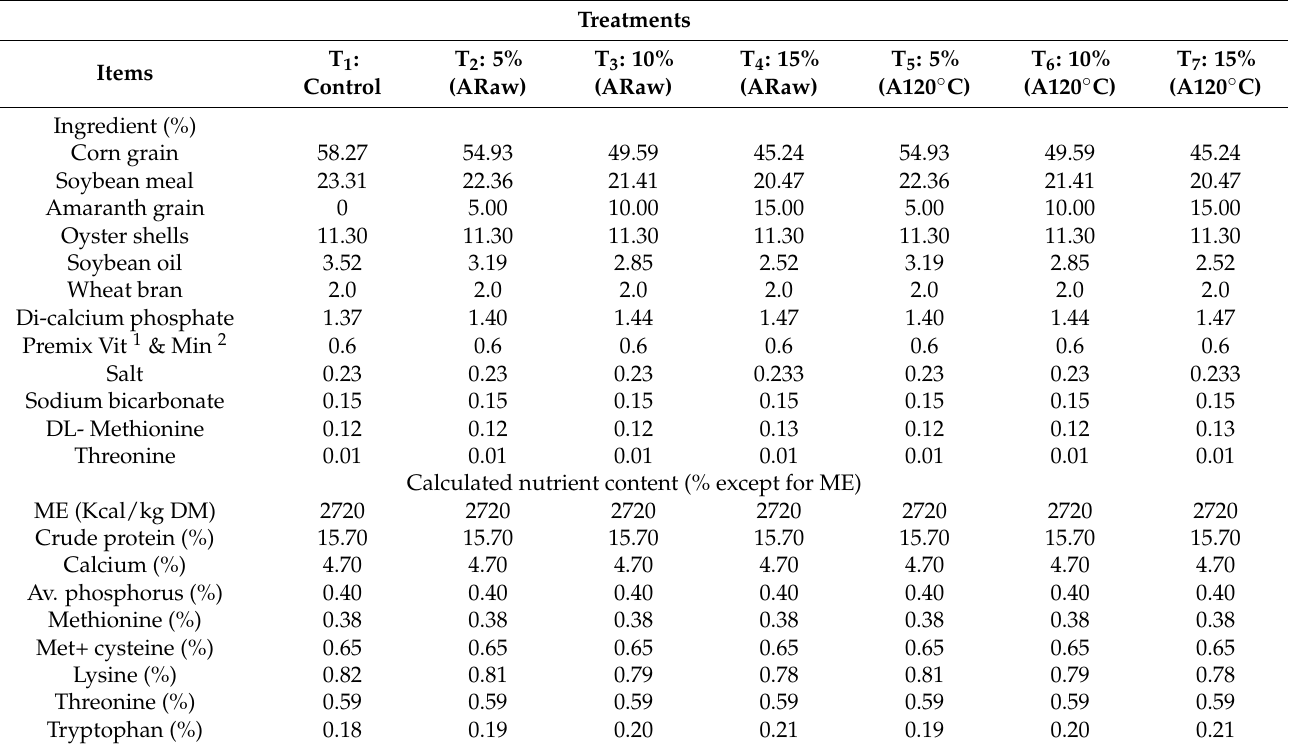
Table 1. Ingredients and chemical composition of trial diets fed based on dry matter (DM) to Hy-line W-36 white leghorn laying